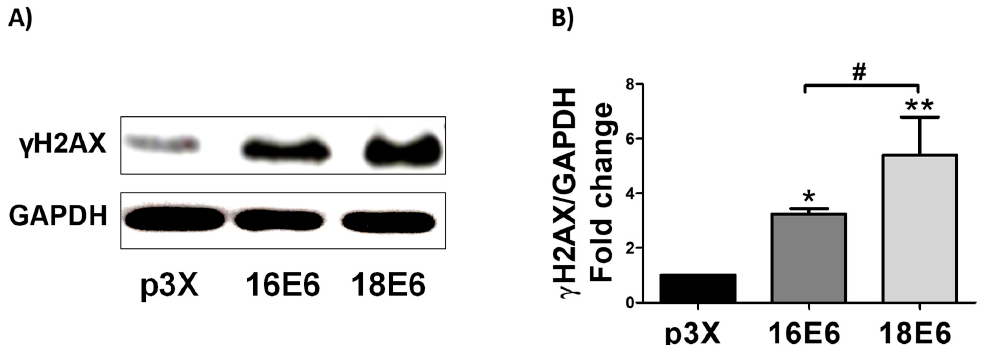
Figure 11. E6 oncoproteins from HPV16 and HPV18 induce DNA damage in FaDu cells. ( A ) Representative immunoblot; and ( B ) quantitative densitometric analysis of gamma H2A histone family member X ( γ H2AX) in FaDu-transfected cells. GAPDH was used as a loading control. Data are expressed as the mean ± SD. Tukey’s test * p < 0.05 and ** p <0.005 vs. p3X control; # p < 0.05 16E6 vs. 18E6, n =